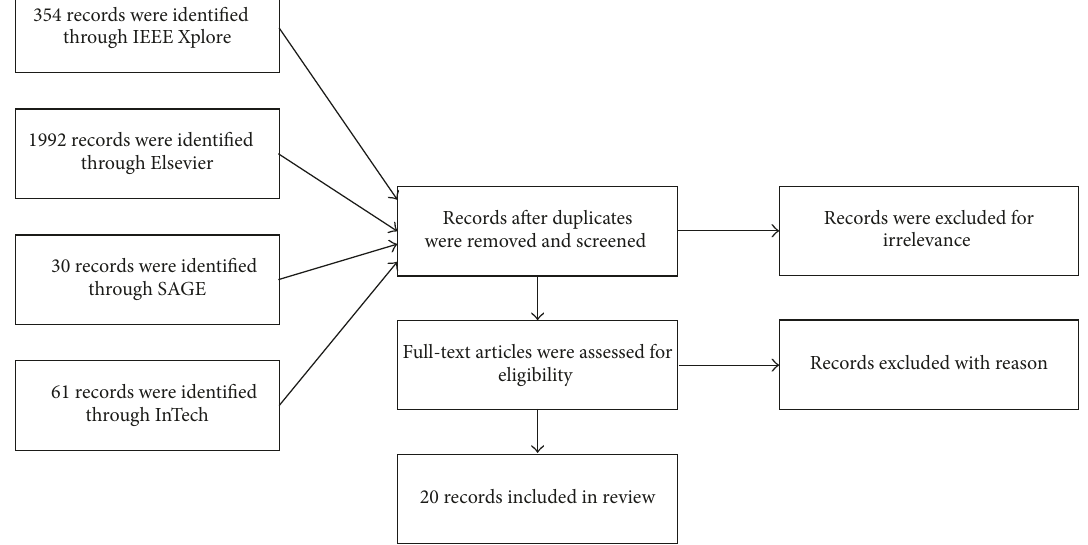
Figure 6: PRISMA flow diagram of the literature review process